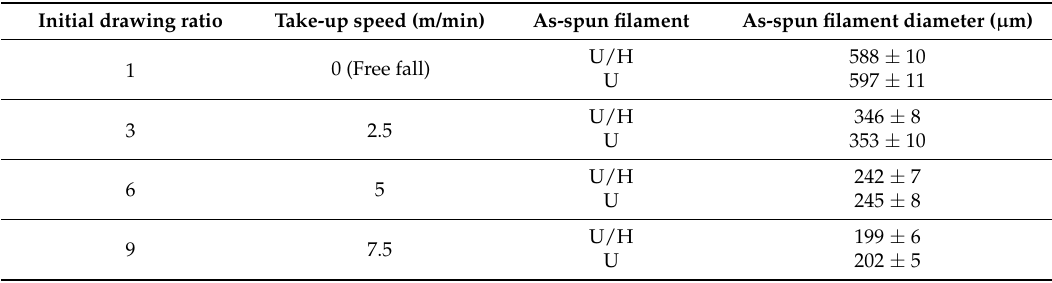
Table 2. Take-up speeds of the winder and as-spun filament diameters with different initial drawing ratios.